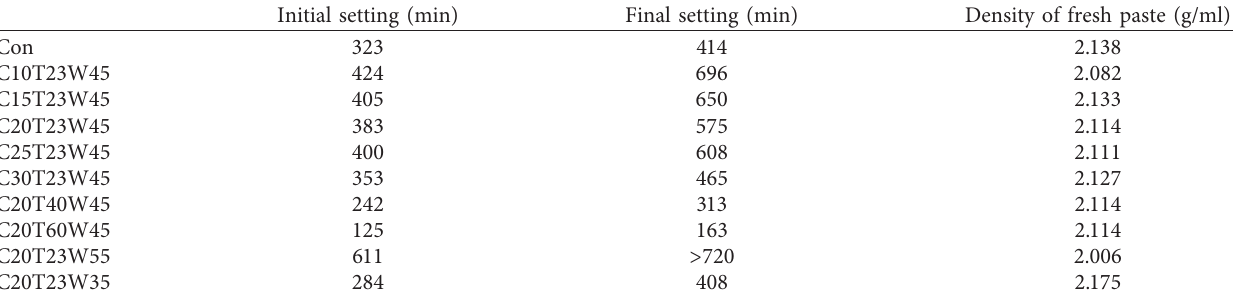
Table 3: Setting times and densities of fresh